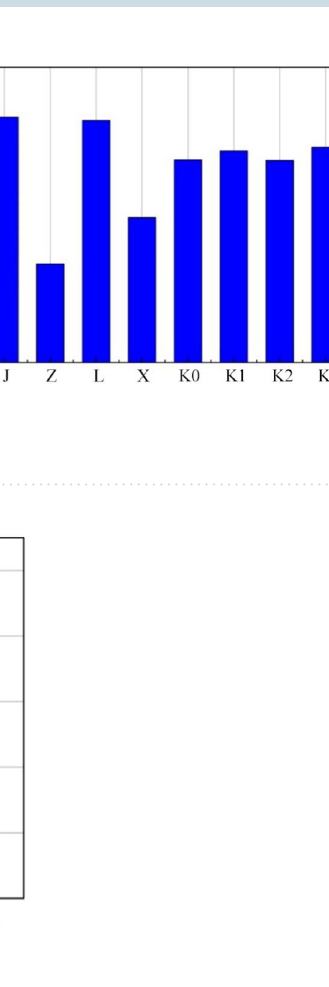
Figure 15. Changes in the percentage of 0–100 nm pores with pore fractal dimension.